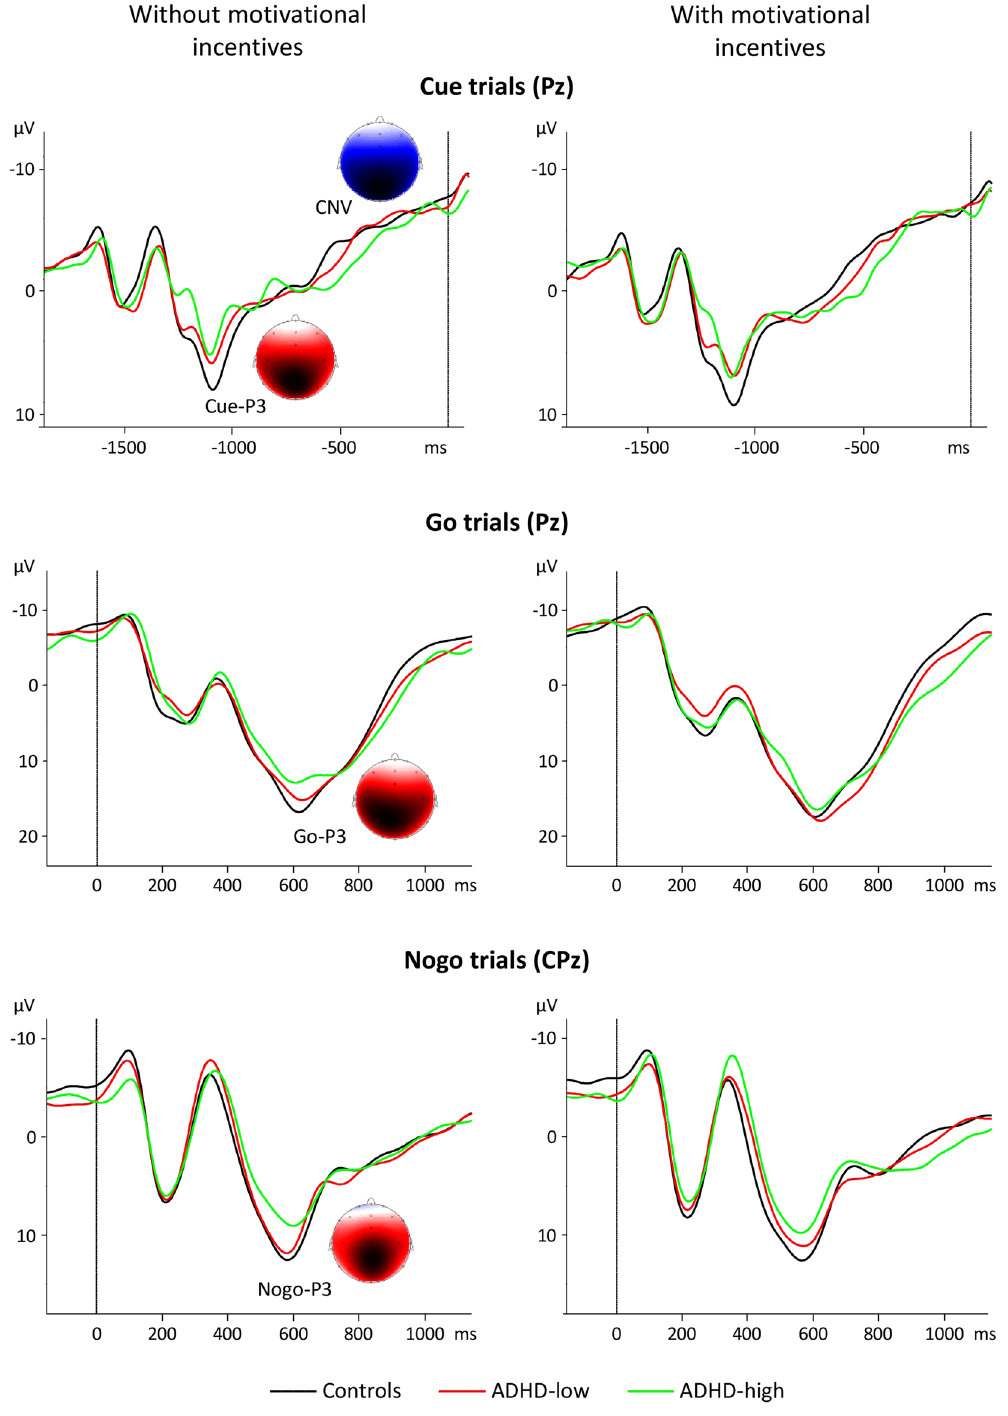
Figure 1. Grand average event-related potentials for boys with FBB-ADHS total scores ≤ 0.5 (controls; black curves), boys with FBB-ADHS total scores > 0.5 and ≤ 1 (ADHD-low; red curves) and boys with FBB-ADHS total scores > 1 (ADHD-high; green curves). Top: ERPs following cue stimuli (electrode Pz), middle: ERPs following go stimuli (electrode Pz), bottom: ERPs following nogo stimuli (electrode CPz). Signals obtained for the without-incentives (resp. with-incentives) condition are shown on the left (resp. right) side. Time point 0 ms refers to the onset of the S2 stimulus. Topographies of Cue-P3, CNV, Go-P3 and Nogo-P3 in the control group for the without-incentives condition are also depicted. Blue and red colours indicate negative and positive amplitude values,